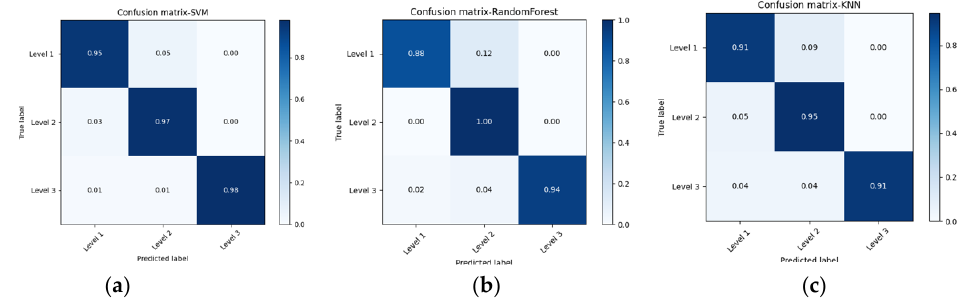
Figure 15. Confusion matrix of machine learning algorithm: ( a ) SVM, ( b ) RF, ( c ) KNN.